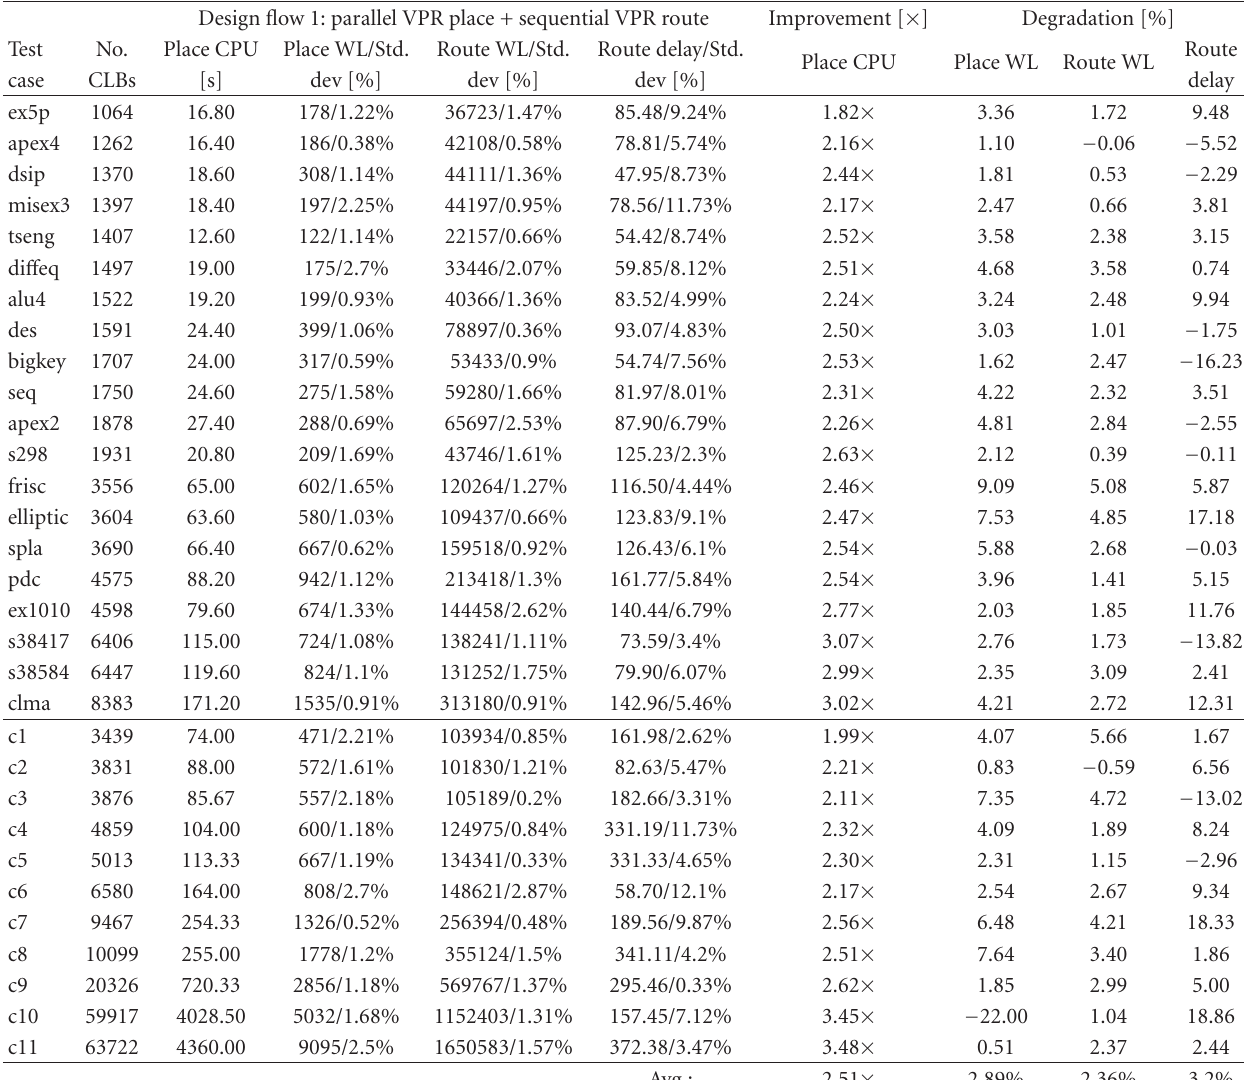
Table 1: Comparison of sequential and parallel VPR placement algorithms. Negative numbers from the last three columns signify actual improvements and not degradations. The first twenty test cases are VPR 4.3 test cases and the remaining eleven test cases are VPR 5.0 test cases.